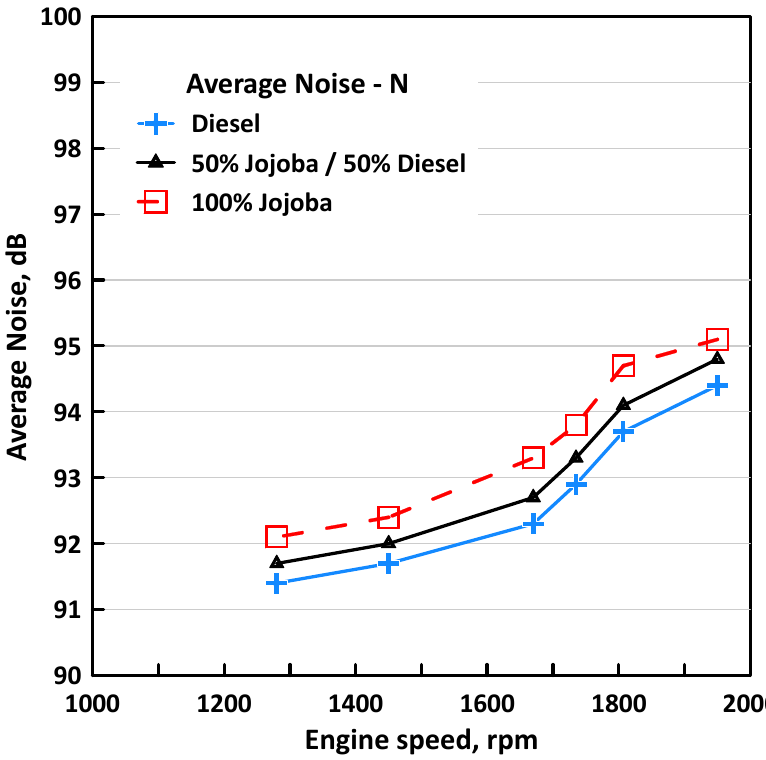
Figure 13. Average noise measured by average noise meter.